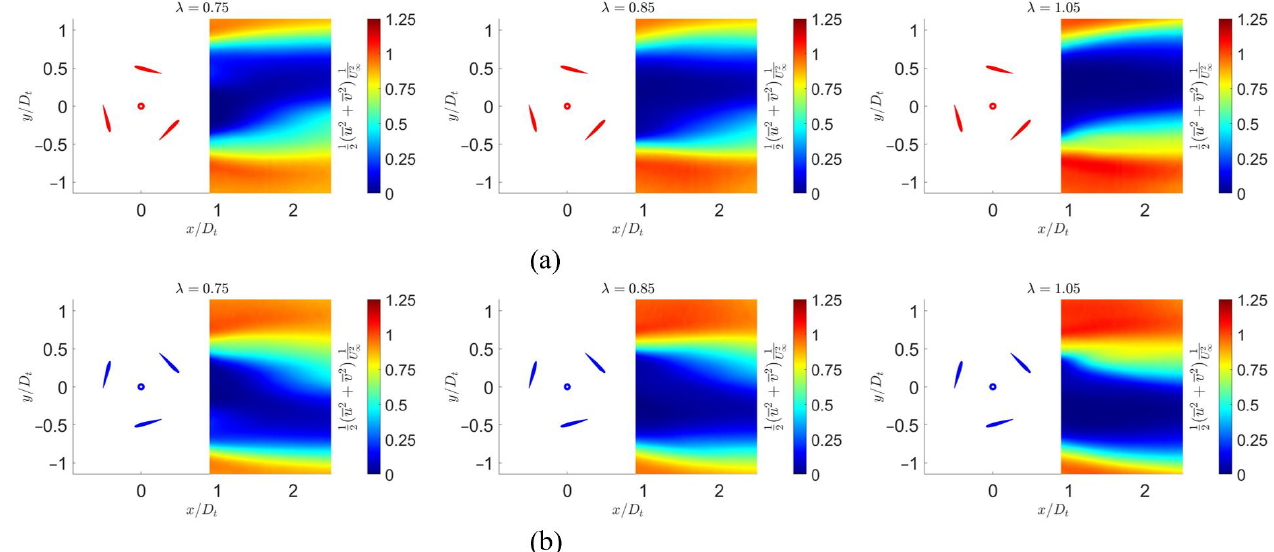
Figure 14. The time -averaged kinetic energy of the flow behind turbine T1 ( a ) and turbine T2 ( b ). The red circle displays turbine T1 rotation center, while the blue circle displays turbine T2 rotation center.